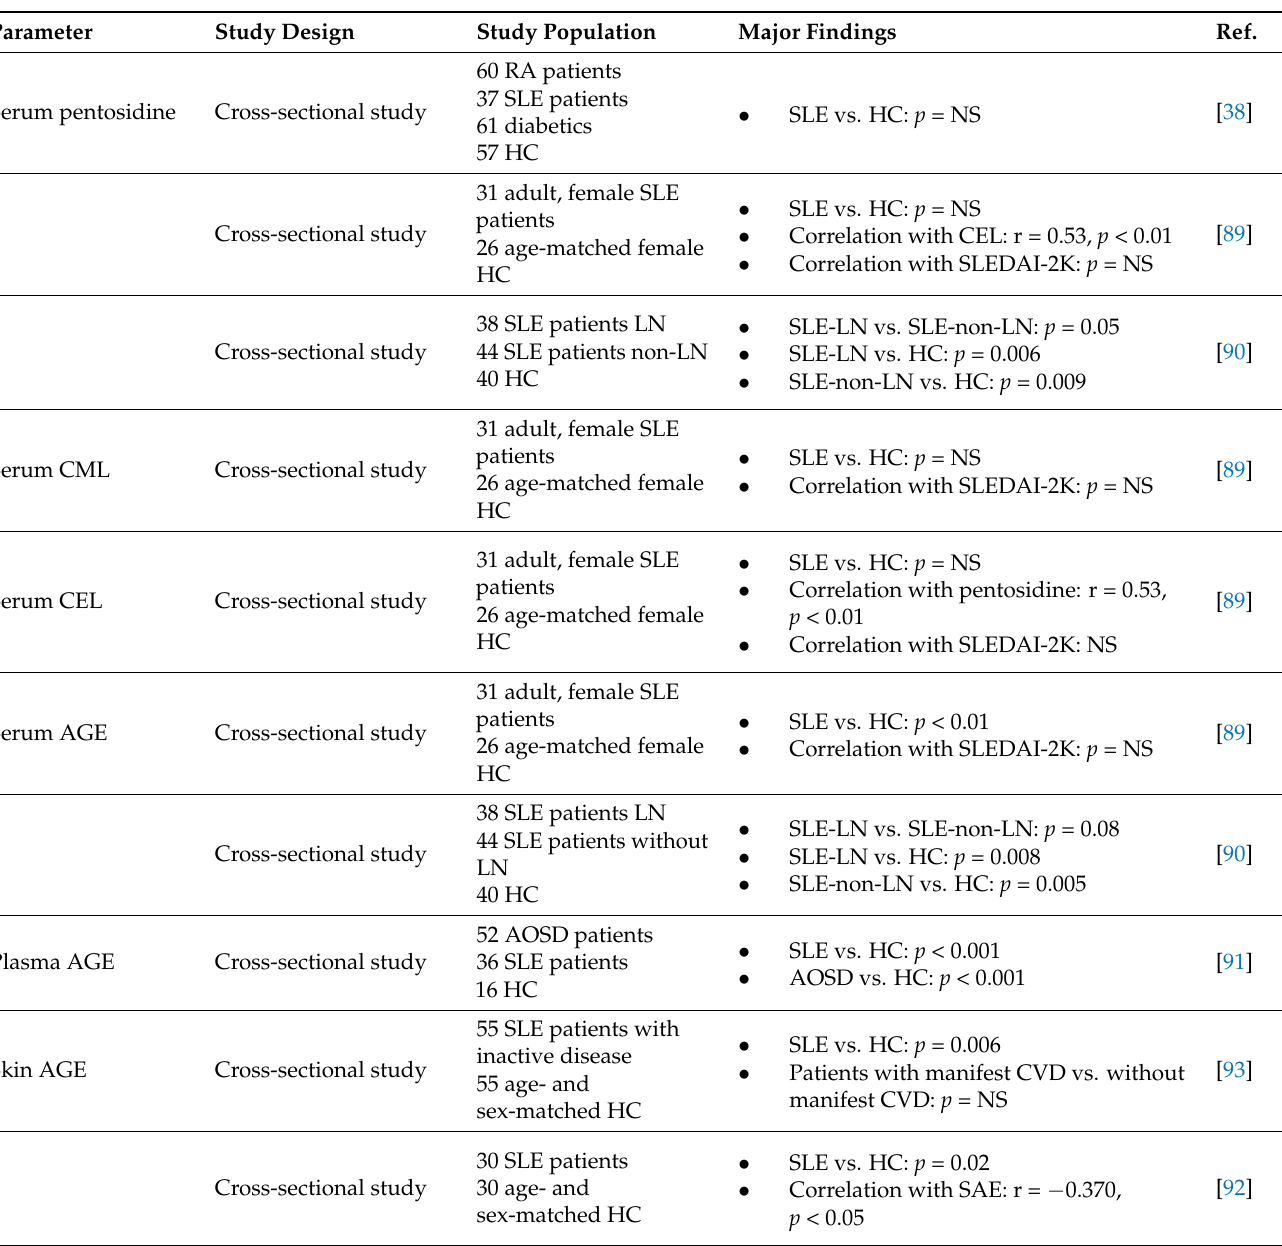
Table 2. Overview of studies investigating advanced glycation end products (AGEs) and the (soluble) receptor for AGEs [(s)RAGE] in systemic lupus